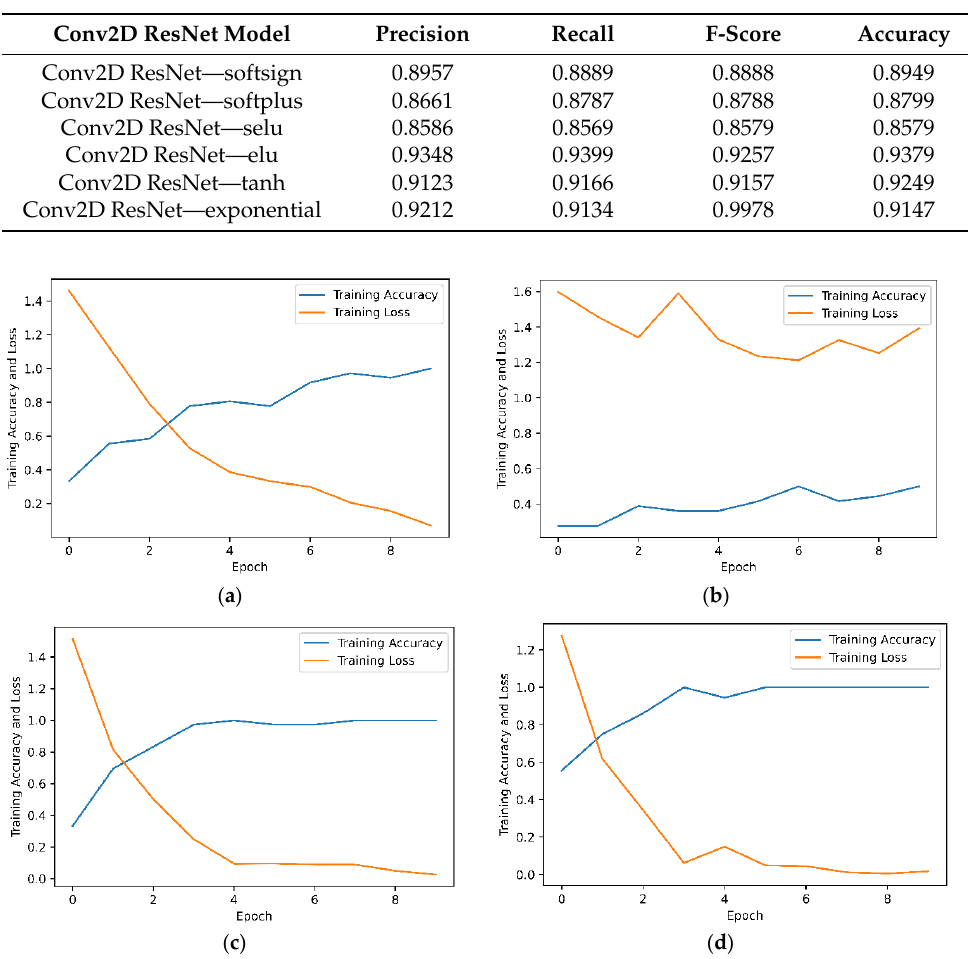
Figure 5. Model loss and accuracy of Conv2D models during training. ( a ) Xception; ( b ) VGG19; ( c ) DenseNet; ( d ) ResNet.